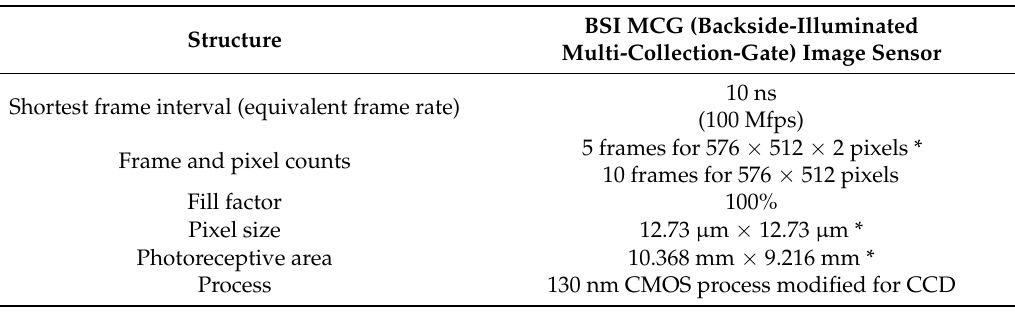
Table 2. Specification of the test